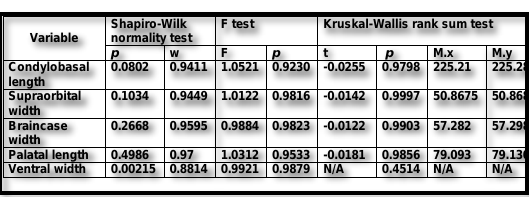
Table 1. The Shapiro-Wilk normality test , F test, and Kruskal-Wallis rank sum test results, for five measured variables recorded by caliper and PMSc® ( P = Significance, F = f value for f test, t = value for t-test, w = value for Shapiro test, M.x = mean for x , M.y= mean for y). The SPSS software package 21.0 (SPSS Inc. IBM, South Africa) and R software package 2.14.2 (R development Core team 2012) were used to perform basic statistics. The test for normality showed that the data was normally distributed in four variables not the fifth, the vertical width (Table 1). All variables subjected to analysis of variance (F test) between the two methods, caliper, and PMSc® (Table 1), showed no significant differences between the two methods. The normally distributed data for four variables, braincase width (BW), Condylobasal length (CBL), palatal length (PL), supraorbital width (SOW) subjected to Welch Two Sample t-test, and the non- normally distributed ventral width (VW) subjected to Kruskal-Wallis rank sum test (Table 1), showed that the two methods produced similar results. However, in Box- plot, for CBL (Fig 2) PMSc® is shown to be more sensitive to the variations present. The value of p for all five recorded variables was very high (0.45 to 0.99) indicating that the methods produce similar results. Of the five variables used, one (supraorbital process p=0.999) showed a very strong factor of similarity, followed by the braincase width (p=0.990). The PMSc® is sensitive to minute variations as it detects more outliers, which can be identified in CBL